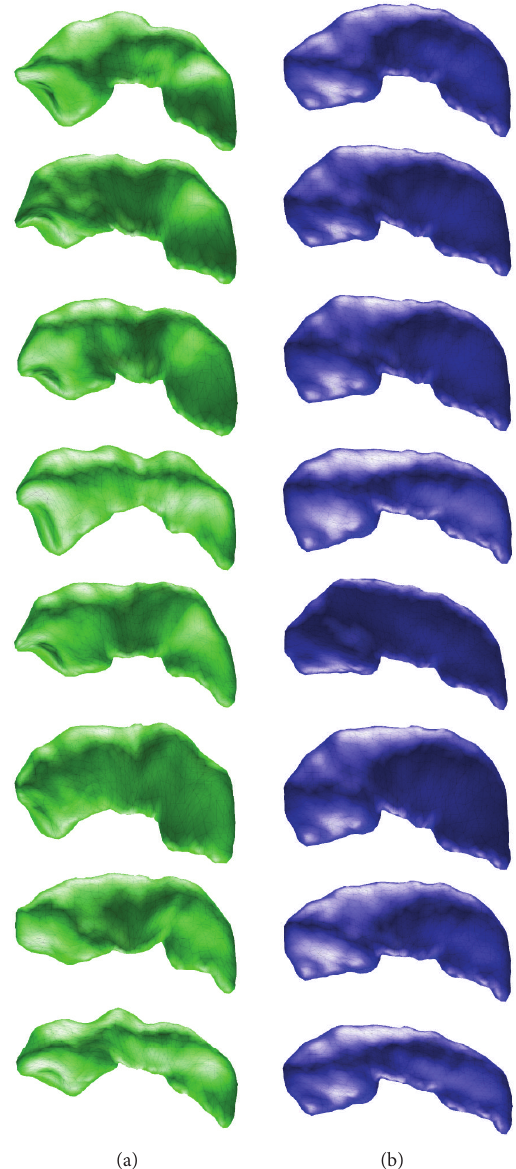
Figure 5: Segmentation results for standard landmark matching (left/green) and GDAS landmark matching (right/blue), for an additional 8 examples demonstrating GDAS overcoming common